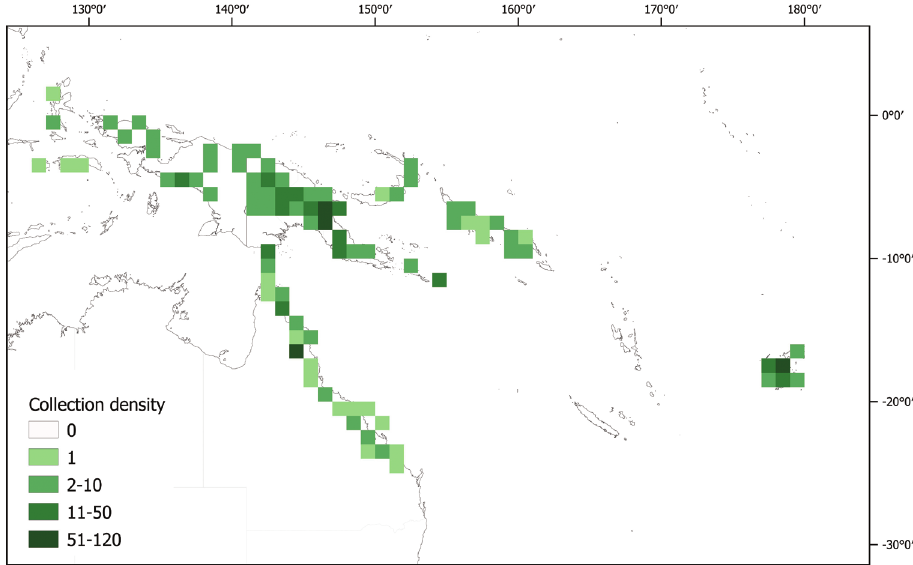
Figure 1. Map of all collections examined for Lycianthes in the area treated in this monograph (Australia, New Guinea and the Pacific). Darker squares indicate those with more